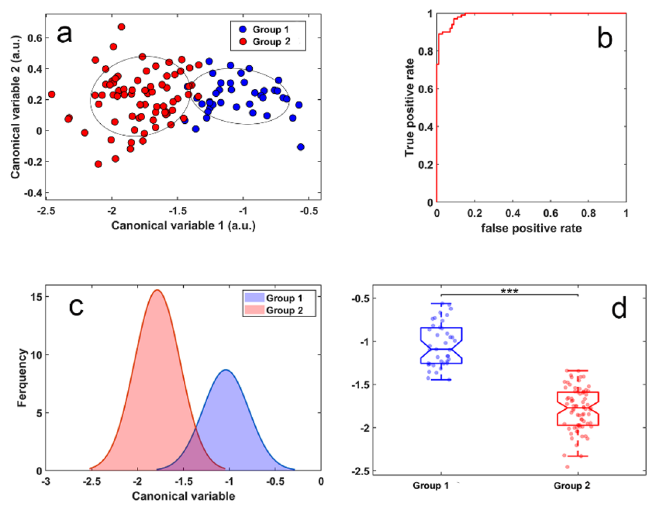
Figure 6. Differentiation of cells from patients with low and high eGFR levels using ten features. ( a ) Clustering of cells in the two cell groups (group1 and 2 has 41 cells and 84 cells respectively) under investigation. Symbols represent individual cells. ( b ) ROC curve for our obtained cell classifier (AUC = 0.99), ( c ) cell distribution histogram, ( d ) boxplots corresponding to the cell classifier evaluated in ( b ). Symbols represent individual cells, p <